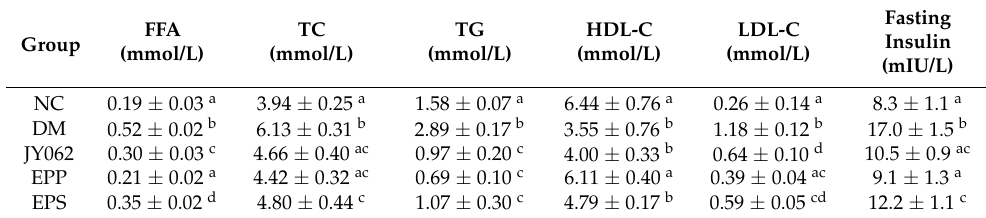
Table 4. Effects of dietary intervention on serum FFA, TC, TG, HDL-C, LDL-C and insulin in